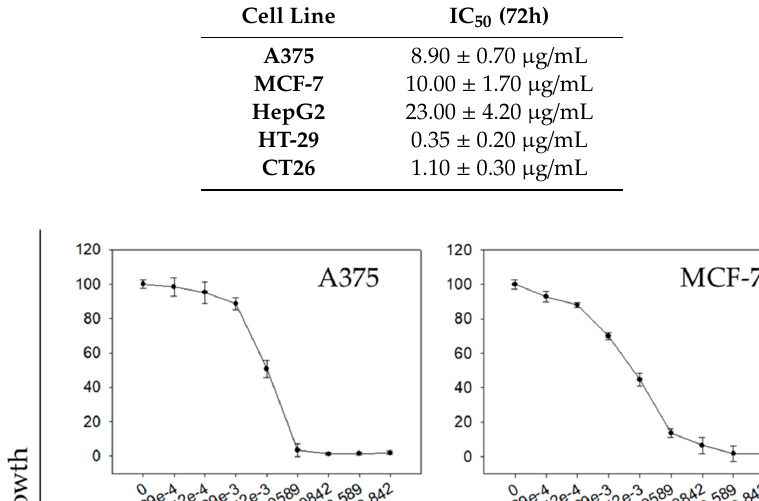
Figure 2. Time-dependent in vitro anticancer activity of OOEO against colon cancer cell lines. Antiproliferative effect of increasing doses of OOEO at 72 h (solid lines, circles) or 48 h (dashed lines, triangles) on human (HT-29) and mouse (CT26) colon cancer cells. Cell growth percentage was